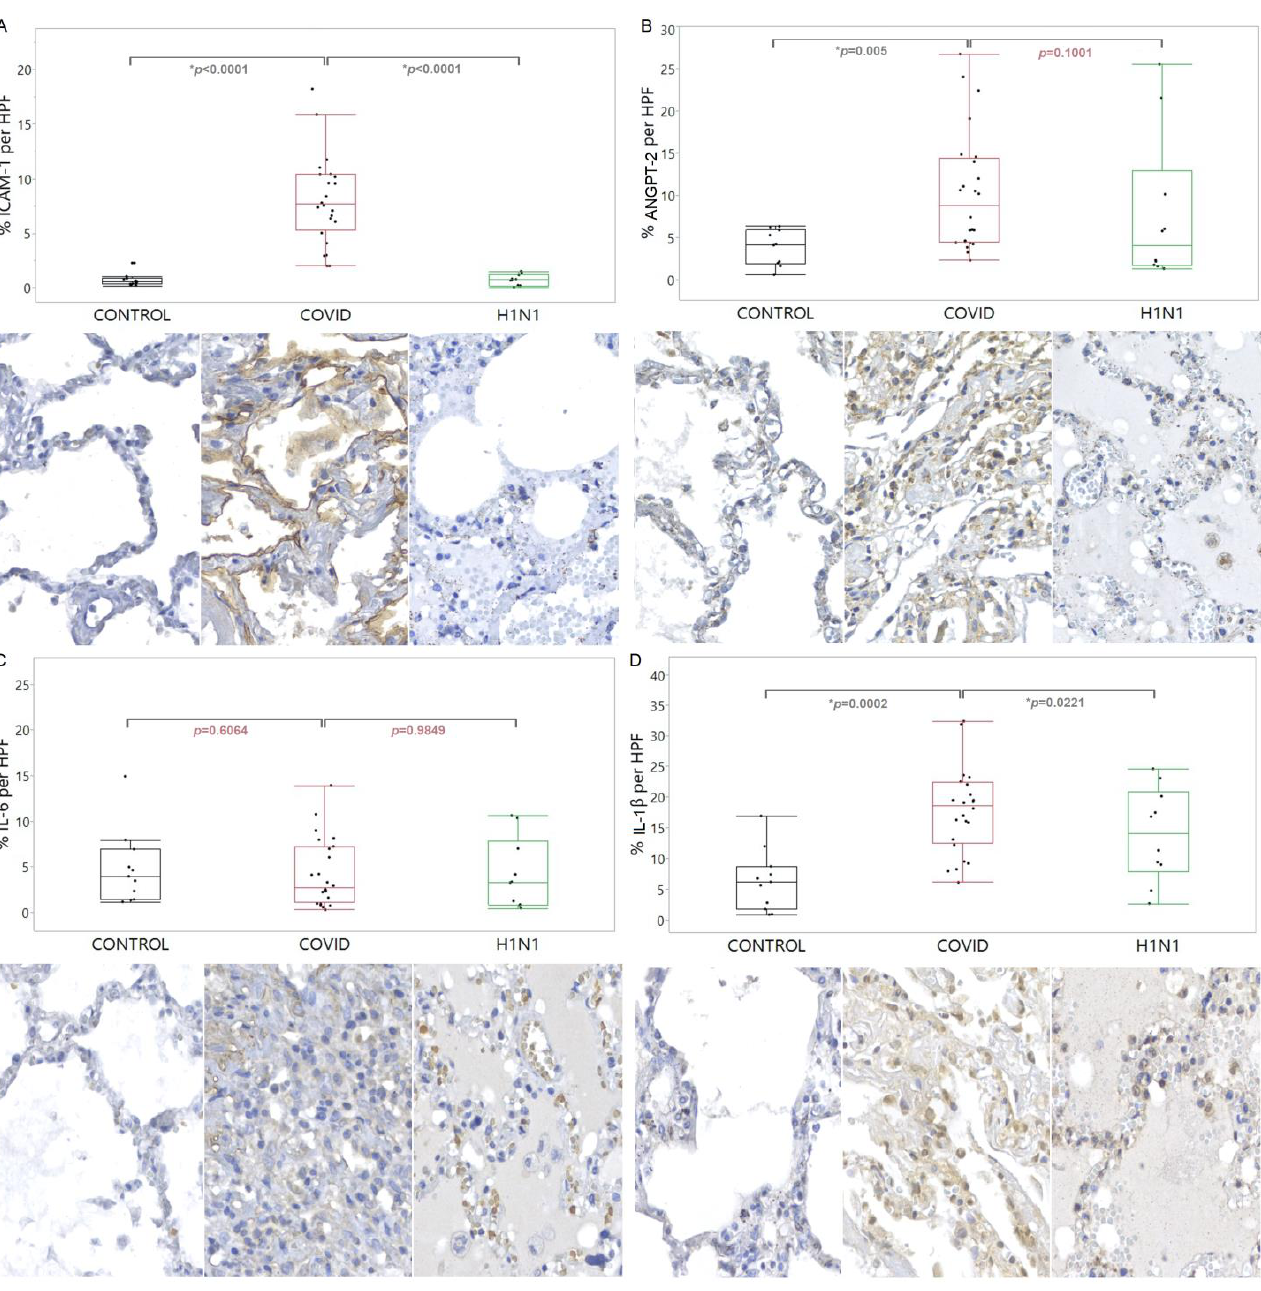
Figure 1. Compares the levels of ICAM-1 ( A ), ANGPT-2 ( B ), IL-6 ( C ), and IL-1 β ( D ) proteins in tissue samples from COVID-19 patients versus control and H1N1pdm09 patients. The data is presented as a graphical representation of the comparison between the groups and the corresponding immunohistochemistry staining images. The difference between the groups was determined using the non-parametric Kruskal-Wallis test. When there was significance, the Mann-Whitney test was applied in the two-by-two comparison, with significance (*) indicated by a p -value less than 0.05. Regarding the PAI-1, there was a lower tissue expression in COVID-19 compared with the CONTROL group ( p = 0.0276). These findings are shown in Figure